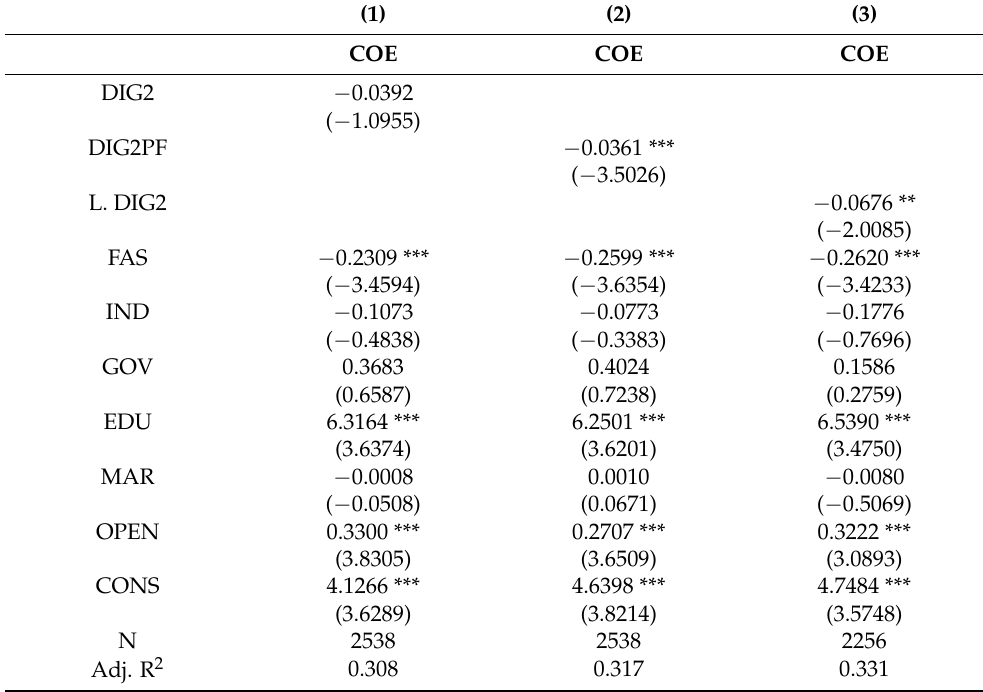
Table 5. Robustness test of changing the digital